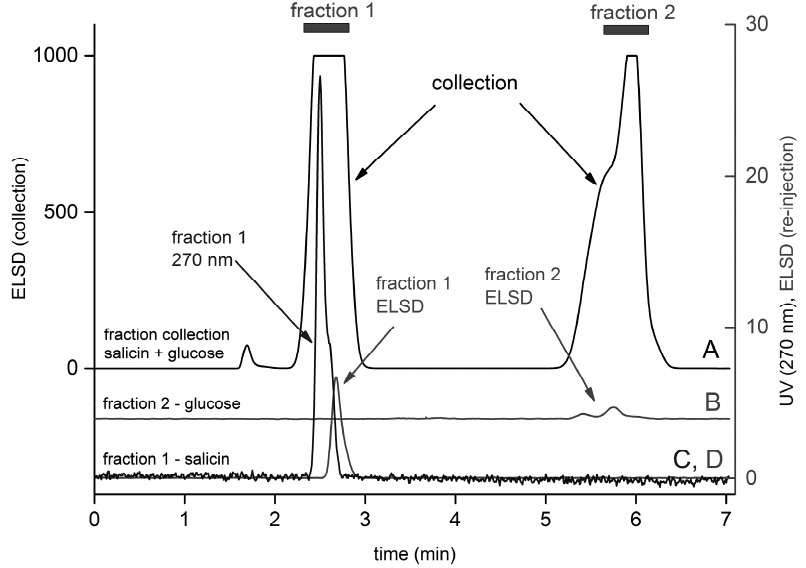
Figure 6. Fraction collection and re-injection of a model mixture. Chromatogram A is the ELSD signal used for fraction collection (fraction1 and fraction 2 were collected within the marked time